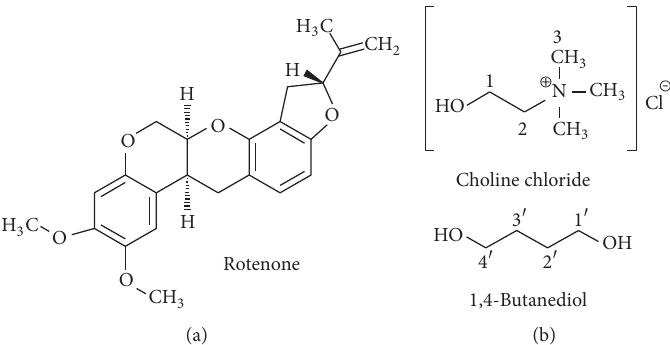
Figure 1: Molecular structure of (a) rotenone and (b) alcohol-based deep eutectic solvent (DES).